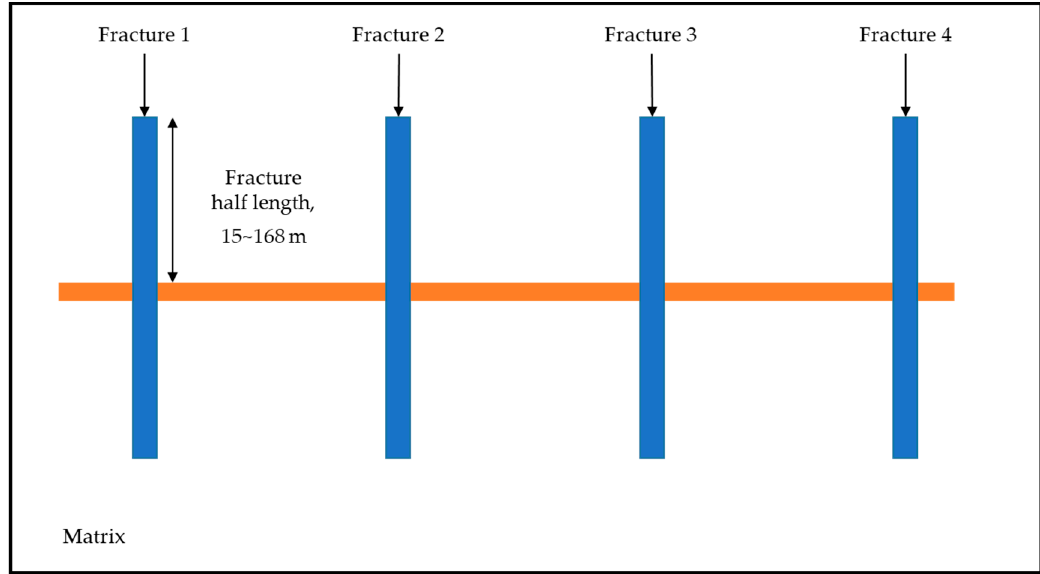
Figure 10. Schematic diagram of the hydraulic fracture design.